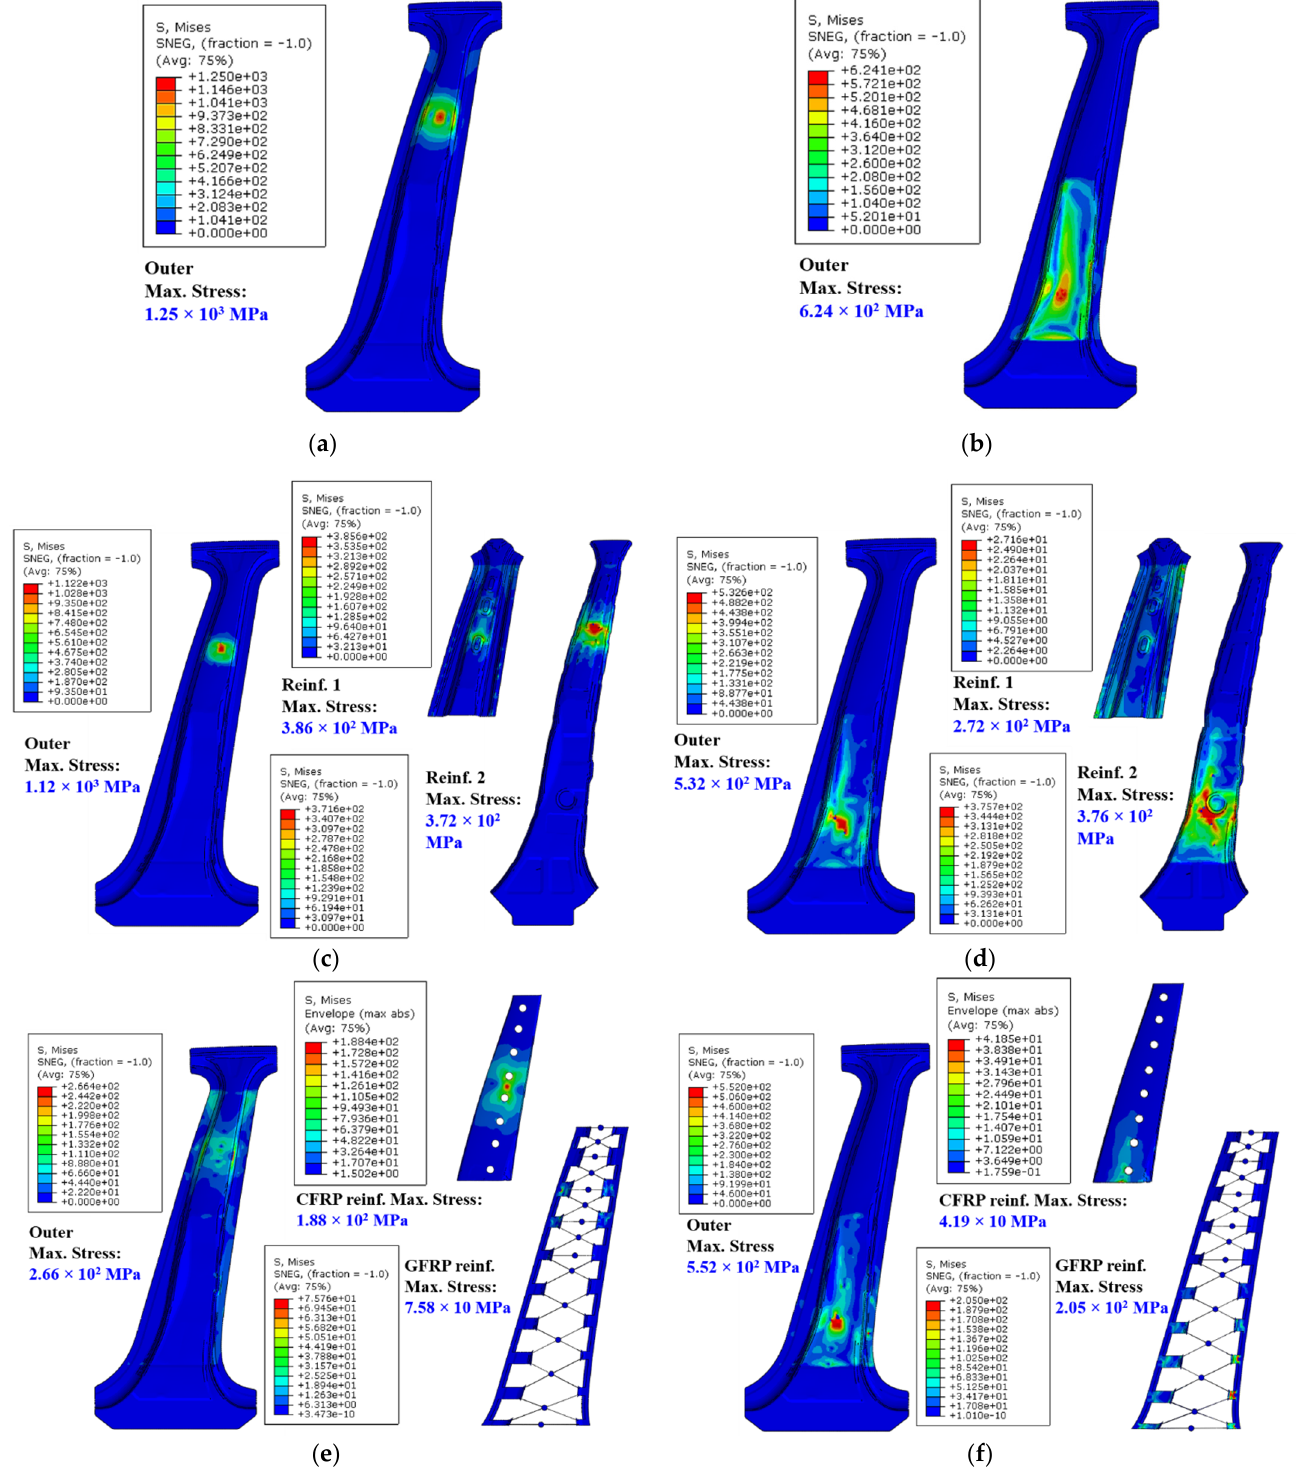
Figure 17. Von Mises stress contour results under upper and lower bending conditions. ( a ) Upper bending load condition—Steel outer only. ( b ) Lower bending load condition—Steel outer only. ( c ) Upper bending load condition—Center pillar with steel reinforcements. ( d ) Lower bending load condition—Center pillar with steel reinforcements. ( e ) Upper bending load condition—Center pillar with composite reinforcements. ( f ) Lower bending load condition—Center pillar with composite reinforcements.